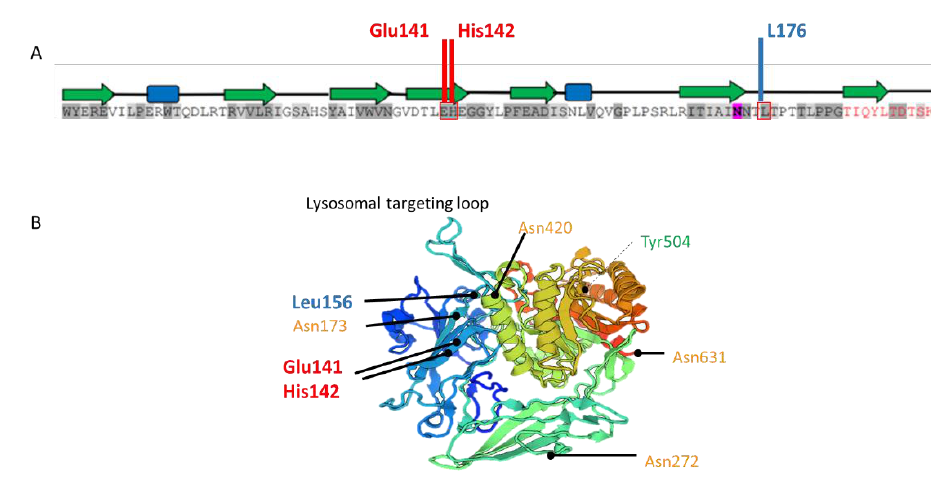
Figure 5. Localization of GUSB mutations. ( A ), Figure adapted from Hassan et al [12,13]. Amino acid sequence of human GUSB centered on the substitutions (in red boxes) carried by the present case. Residues shaded in dark and light grey correspond to degree of conservation between species. Residue highlighted in pink is a glycosylation site. On the top of sequence, in the secondary structure of GUSB, green arrows indicate β -strands and blue boxes correspond to α -helices. ( B ), Three-dimensional structure of GUSB monomer (https: // swissmodel.expasy.org / ). In orange, glycosylation sites; in green, active-site residue; in red and blue, the maternally (c.422A > C;424C > T) and paternally (c.526C > T) inherited mutated residues in the patient, respectively.